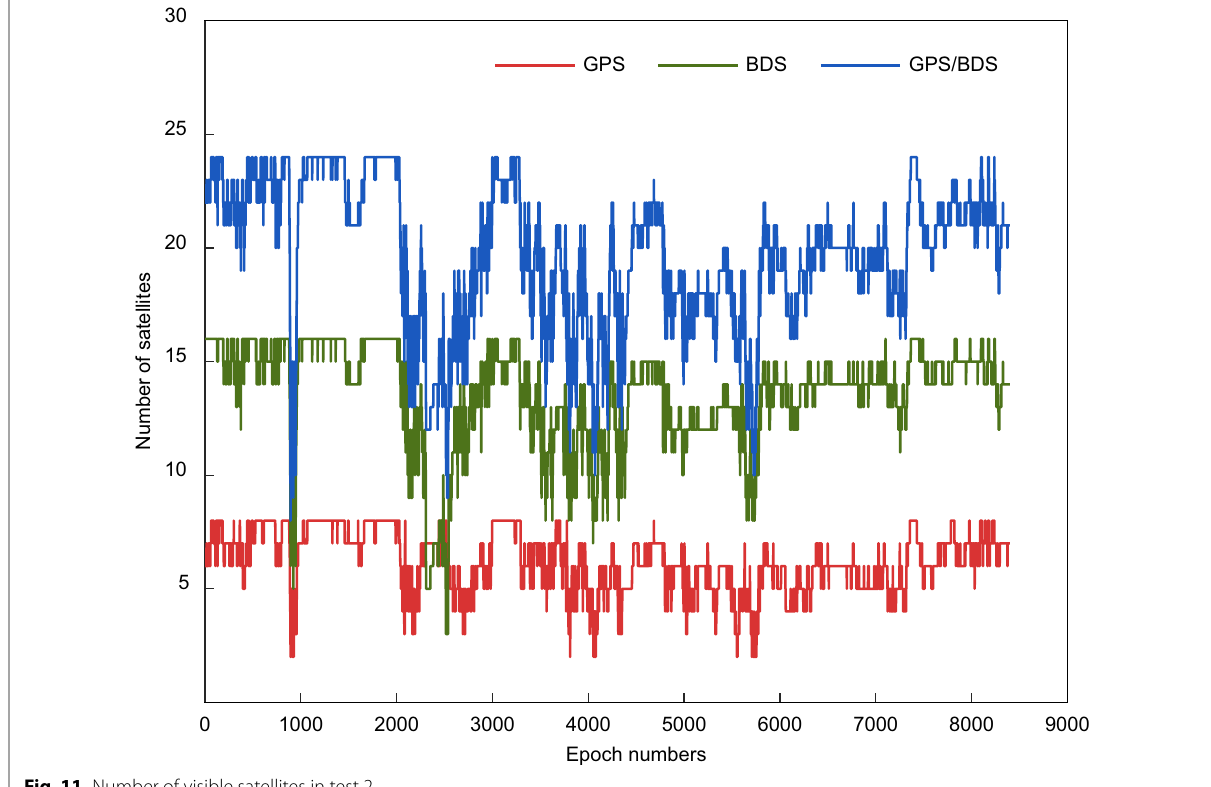
Fig. 11 Number of visible satellites in test 2